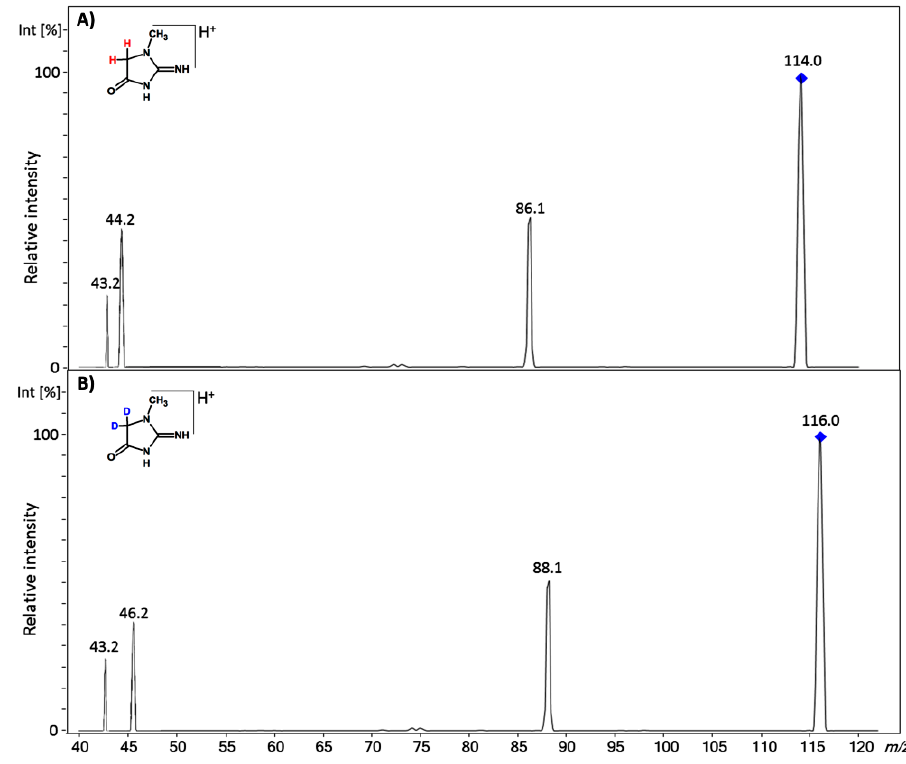
Figure 2. ( A ) ESI-MS/MS spectra of protonated creatinine and ( B ) the obtained deuterated creatinine isotopologue. ( A ) parent ion 114.0, collision energy 45 eV; ( B ) parent ion 116.0, collision energy 45 eV.